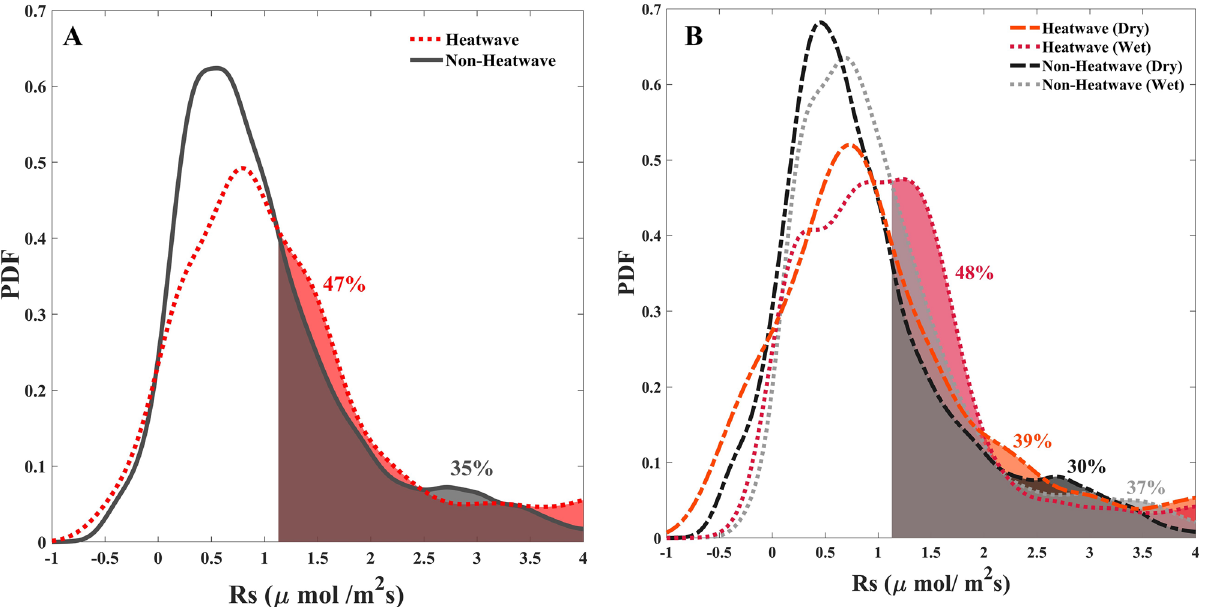
Figure 2. Probability density functions (PDFs) of soil respiration (Rs) for the San Joaquin Marsh Reserve (SJMR) over the study period February 2016 to February 2017. Shaded areas denote soil respiration exceeding the average soil respiration and the percentages indicate the corresponding exceedance likelihoods. ( A ) PDFs of soil respiration given heatwave (red dotted line) and non-heatwave conditions (black solid line). ( B ) PDF conditioned on heatwave/non-heatwave and two soil moisture regimes (i.e., dry and wet